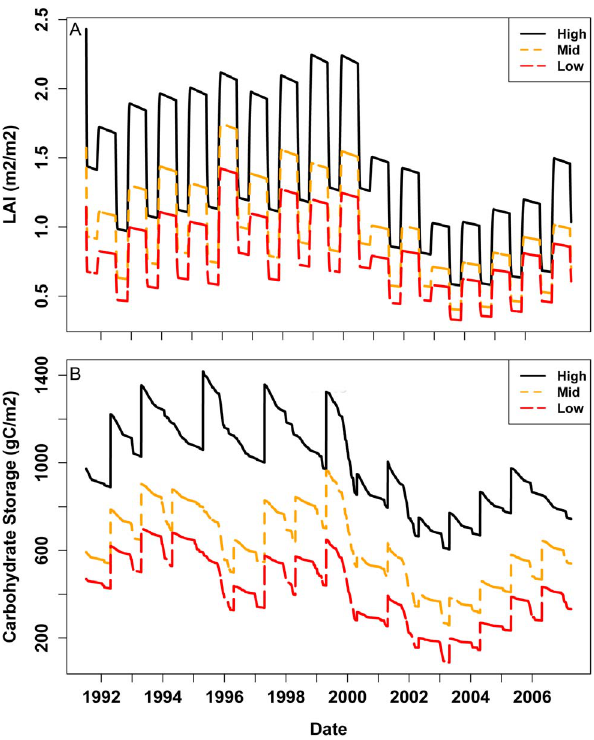
Figure 8. Trajectory of a) LAI and b) Non Structural Carbohy- drate Storage. Trajectories of LAI and NSC are shown for high, mid and low elevation sites for 1992–2007 period. NSC/NPP and MinL/AGC are set to 0.3 and 0.05 respectively. We note that for the low elevation site, we predict that mortality would occur during the drought based on low NSC values. Based on this we could trigger a reduction of LAI to zero. We show predicted LAI without this mortality trigger to illustrate the response of the carbon cycling model and to point out that simply tracking needle loss would not be sufficient to capture the mortality event.